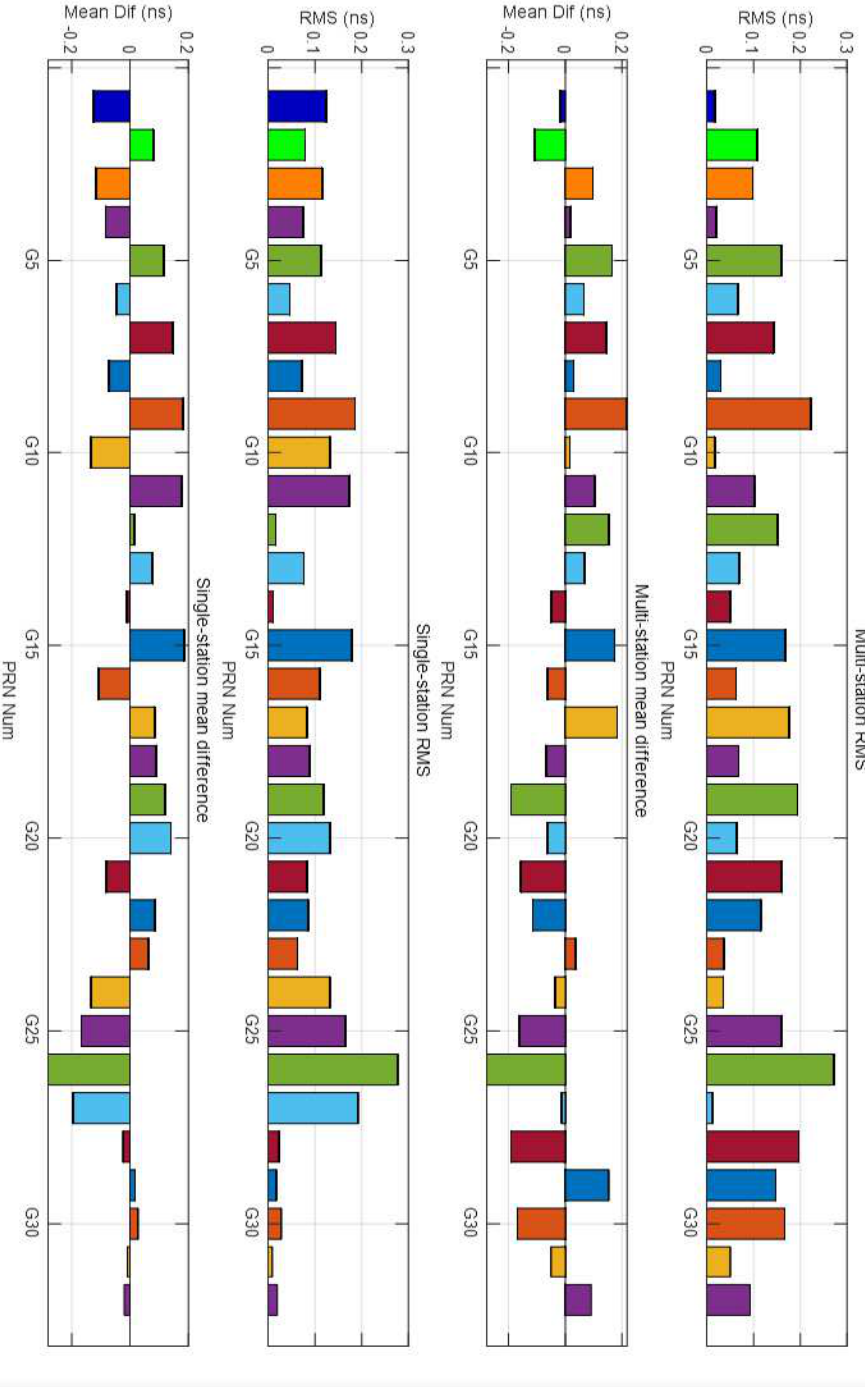
Figure 5. Root mean square (RMS) and mean difference between the multi-station estimated satellite DCBs and Center for Orbit Determination in Europe (CODE) products ( right 2 plot), and RMS and the mean difference between the single-station estimated satellite DCBs and CODE products ( left 2 plot) from 16 August